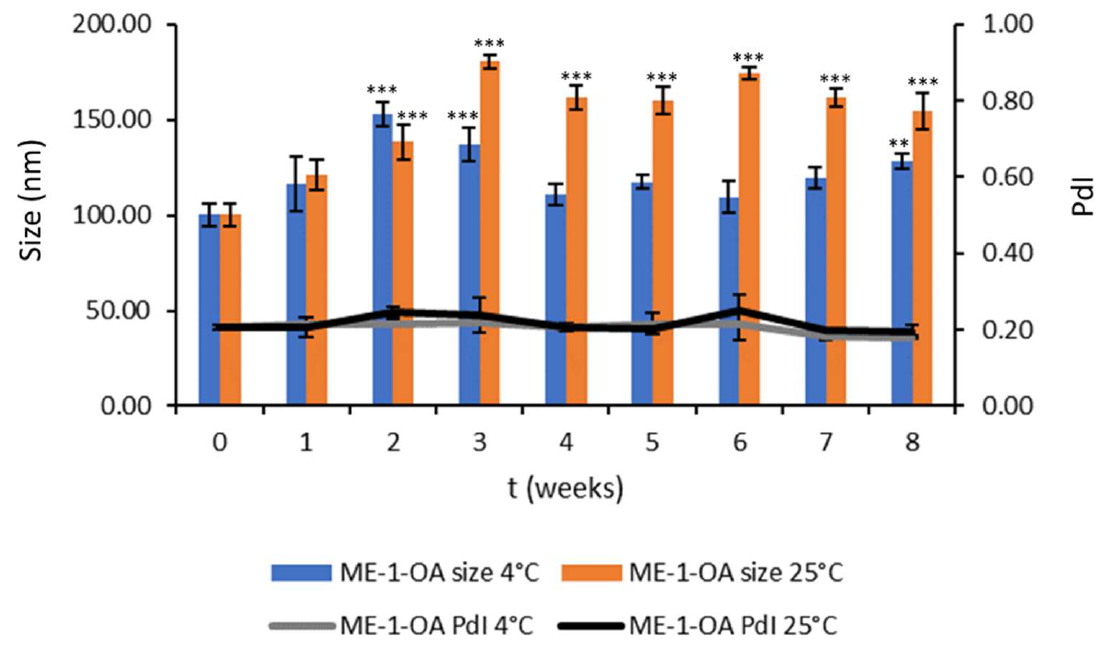
Figure 3. ME-1-OA storage stability study at 4 °C and 25 °C. Values are reported as mean ± SD of three independent experiments. Tukey’s test ( n = 3): ** p < 0.01, *** p < 0.001 vs. time zero.